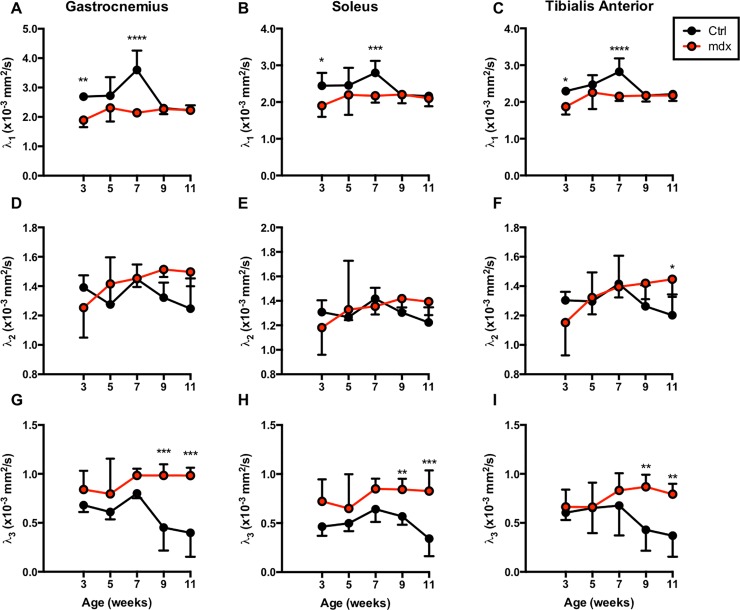
Eigenvalues analyzed for TA, GA, and SOL muscles.Graphs displaying average longitudinal eigenvalues λ1, λ2, and λ3 of mdx4cv and control mouse muscles. λ1 values for mdx4cv mice were significantly lower at the 3- and 5-week time points versus age-matched controls in all muscles (top panels), while λ3 values for mdx4cv mice were significantly higher at 9 and 11 weeks (bottom panels). λ2 values were not significantly different between groups until the 11-week time point in the TA muscle (middle panels). *P ≤ 0.05, **P ≤ 0.01, ***P ≤ 0.001, and ****P ≤ 0.0001.